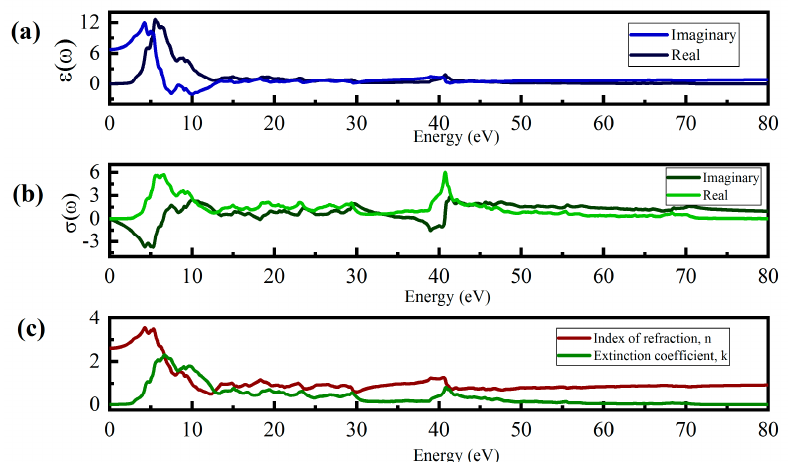
Figure 4. ( a ) Dielectric constant, imaginary and real parts. ( b ) Real and imaginary parts of optical conductivity spectra. ( c ) Refractive index n and extinction coefficient. All properties were calculated using HSE06 .